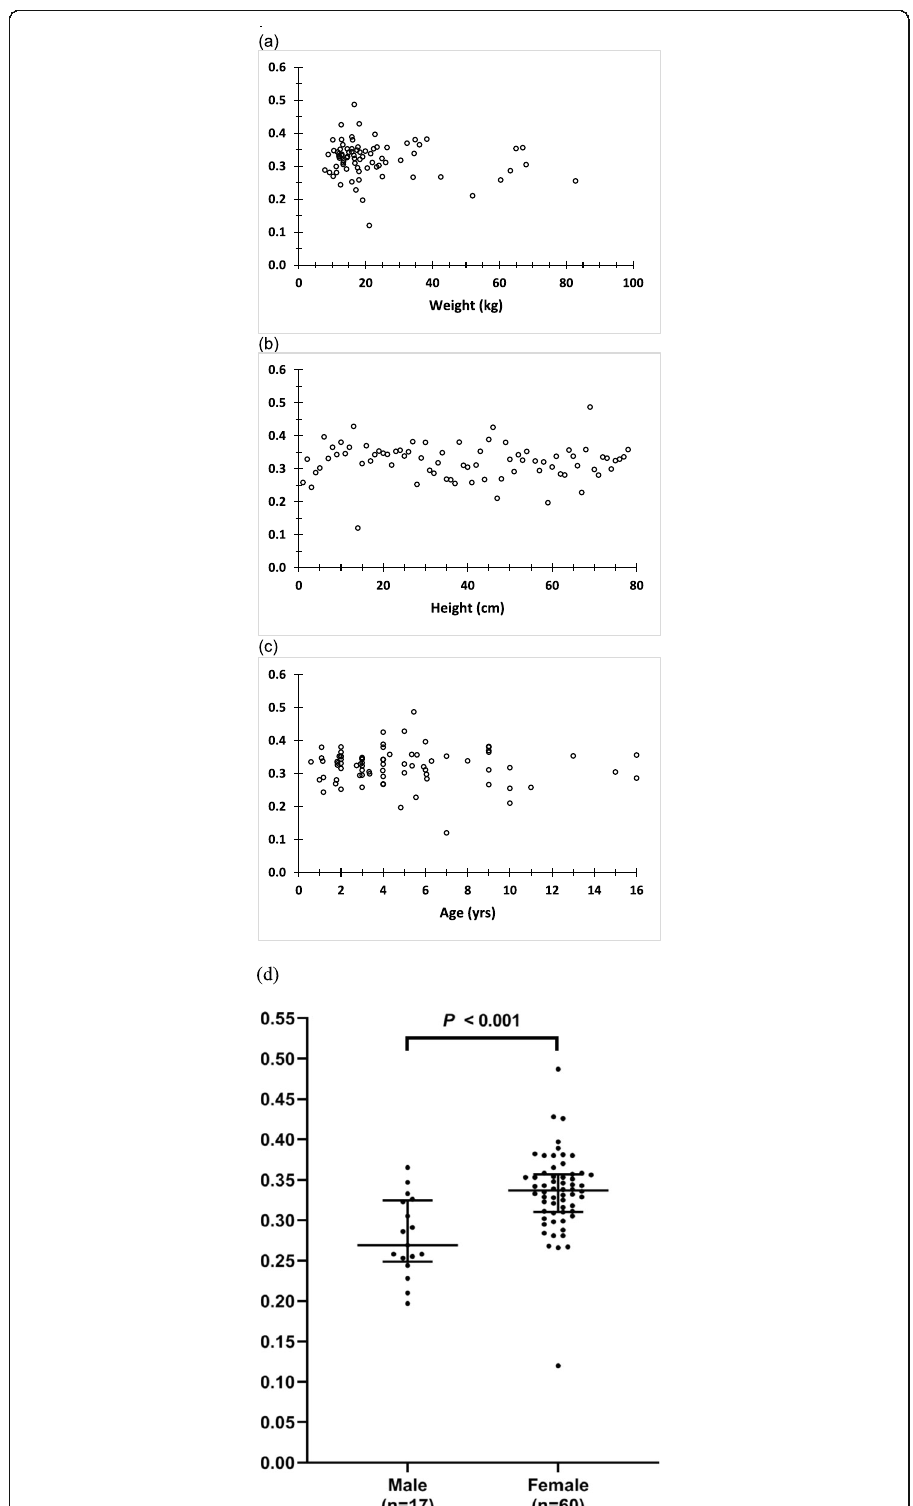
Fig. 5 Kidney activity fraction at the clinical imaging time, approximately 3 h post DMSA administration. Data points shown are from quantitative SPECT imaging versus patient a weight, b height, c age and d gender (middle lines represent medians (50th percentile) and the interquartile ranges (25th – 75th percentiles; top and bottom